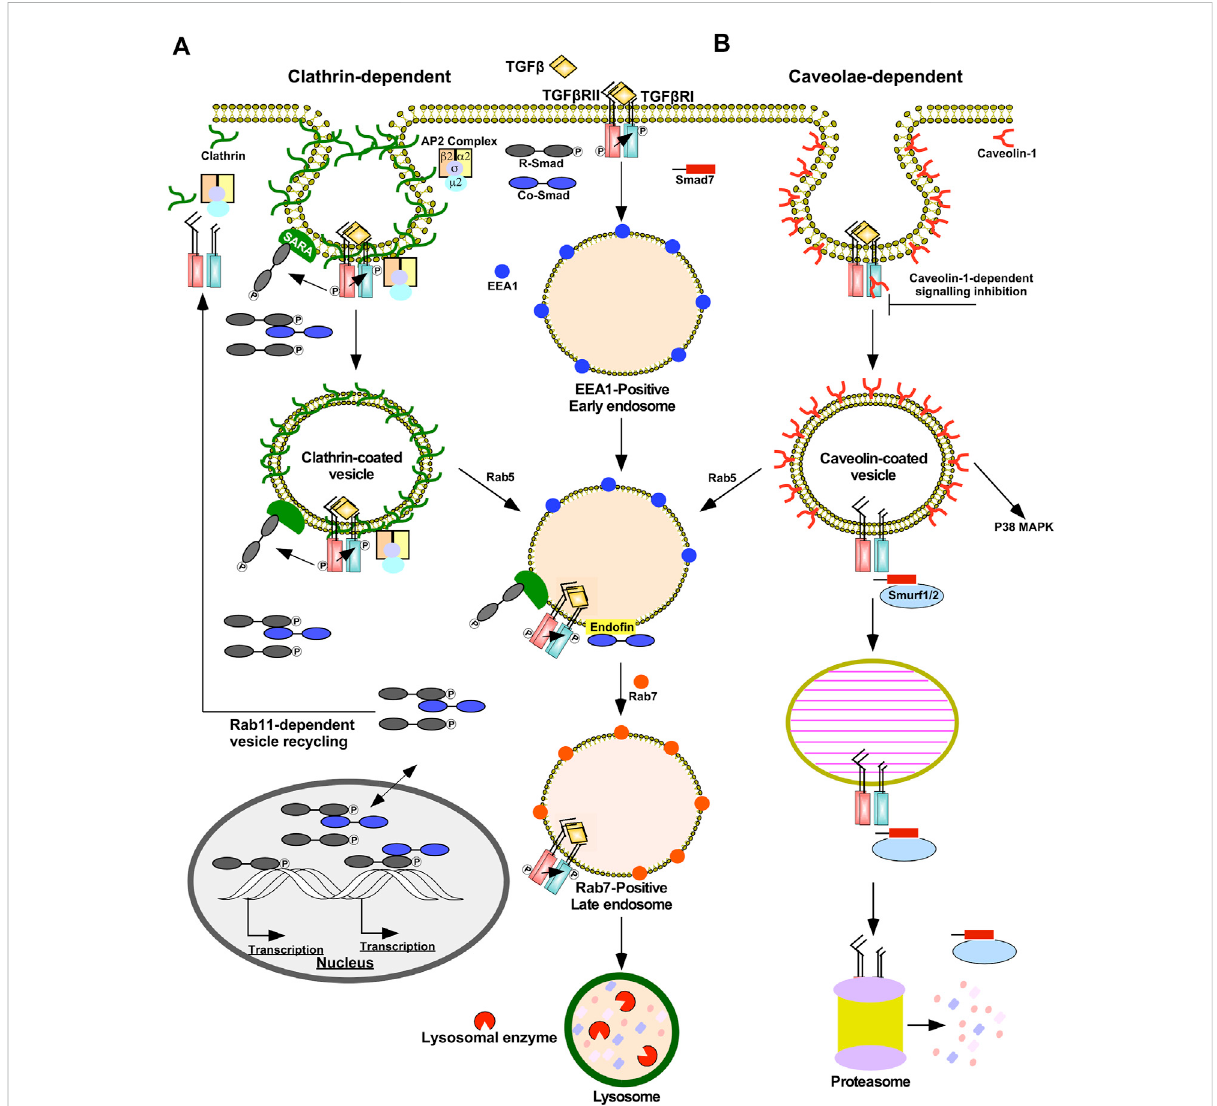
FIGURE 3 Clathrin- and caveolae-dependent endocytosis regulates the duration and strength of TGF β signalling. (A) Clathrin-dependent receptor traf fi cking is mediated by triskelion shaped clathrin proteins (green). Clathrin tethers transforming growth factor- β (TGF β ) receptors to clathrin- coated pits via the β 2 adaptin of the clathrin coat adaptor complex 2 (AP2). Clathrin-coated pits pinch off the plasma membrane to form clathrin- coated vesicles that fuse with early endosome membrane compartments by a Rab5-dependent process. In the presence of TGF β , TGF β receptors within clathrin-coated vesicles are active and phosphorylate downstream signalling molecules, such as Smads. Clathrin-coated pits and vesicles are enriched in Smad anchor for receptor activation (SARA) proteins that bind to R-Smads, which augments TGF β signalling. Early endosomesbindtoFYVEdomain-containingproteins,suchasendo fi nandSARA.Endo fi nenhancesTGF β signallinginearlyendosomesbytethering Smad4 to early endosomes. Clathrin-dependent receptor traf fi cking promotes R-Smad phosphorylation, which subsequently enters the nucleus with and without Smad4 to regulate transcription. The fates of the TGF β receptors subjected to clathrin-dependent receptor traf fi cking involve recycling back to the plasma membrane in Rab11-positive vesicles or lysosomal degradation. Lysosomal degradation occurs after early endosomes mature into Rab7-positive late endosomes, which eventually fuse with lysosomes. (B) Caveolae-dependent receptor traf fi cking is facilitated by caveolin-1 proteins (red). Caveolae-coated vesicles are associated with dampening TGF β signalling; however, non-canonical p38 MAPK signalling requires caveolae-coated vesicles. Caveolin-1 may bind to TGF β receptor type I (TGF β RI) directly and attenuate its kinase activity. Caveolae-coated vesicles are enriched with Smad7-Smurf2 complexes that target TGF β receptors to proteasome-dependent degradation. Prior to degradation, caveolae-coated vesicles may fuse with early endosomes in a Rab5-dependent manner or mature into caveolin-1-positive endosomes known as